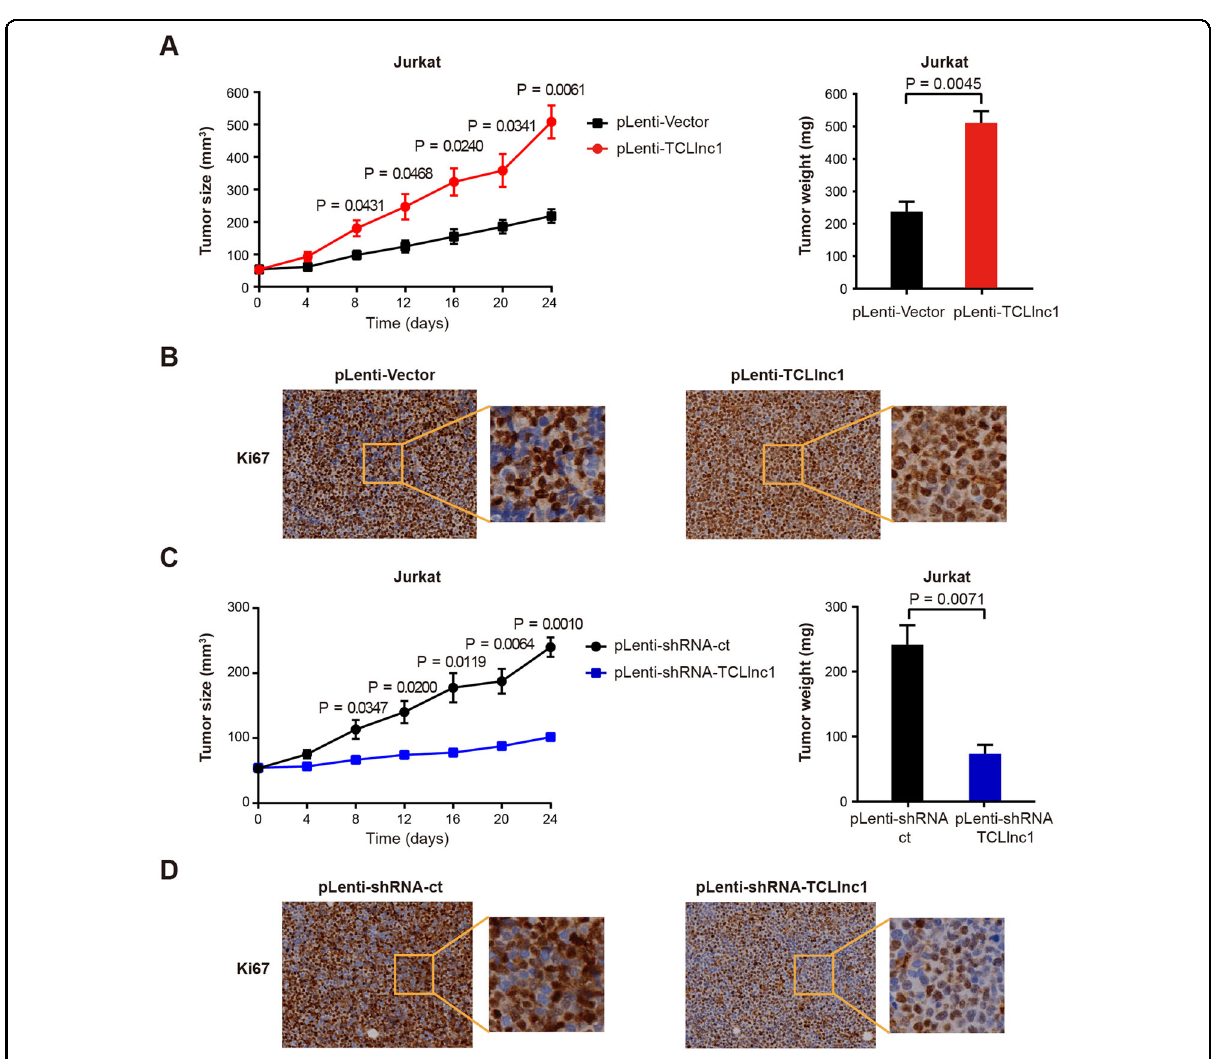
Fig. 4 TCLlnc1 promoted T-lymphoma cell proliferation in vivo. A Tumor volumes and weights of mice injected with pLenti-Vector- and pLenti- TCLlnc1-transfected Jurkat cells. B Immunohistochemistry analysis of Ki-67 in tumors of mice injected with pLenti-Vector- and pLenti-TCLlnc1- transfected Jurkat cells. C Tumor volumes and weights of mice injected with pLenti-shRNA-ct- and pLenti-shRNA-TCLlnc1-transfected Jurkat cells. D Immunohistochemistry analysis of Ki-67 in tumors of mice injected with pLenti-shRNA-ct- and pLenti-shRNA-TCLlnc1-transfected Jurkat